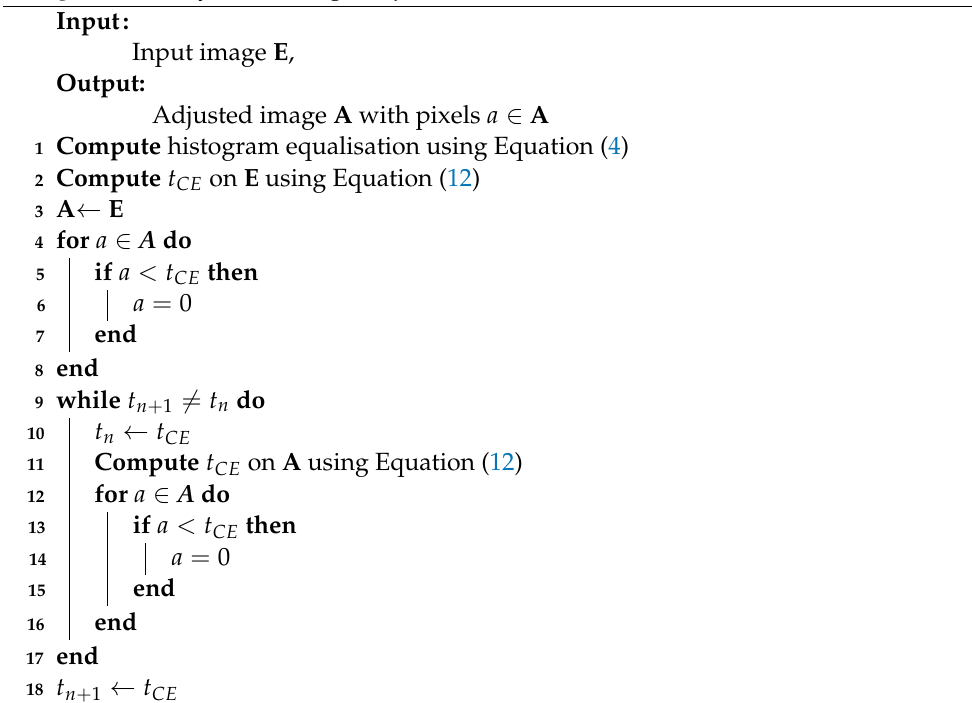
Algorithm 1: Dynamic Range